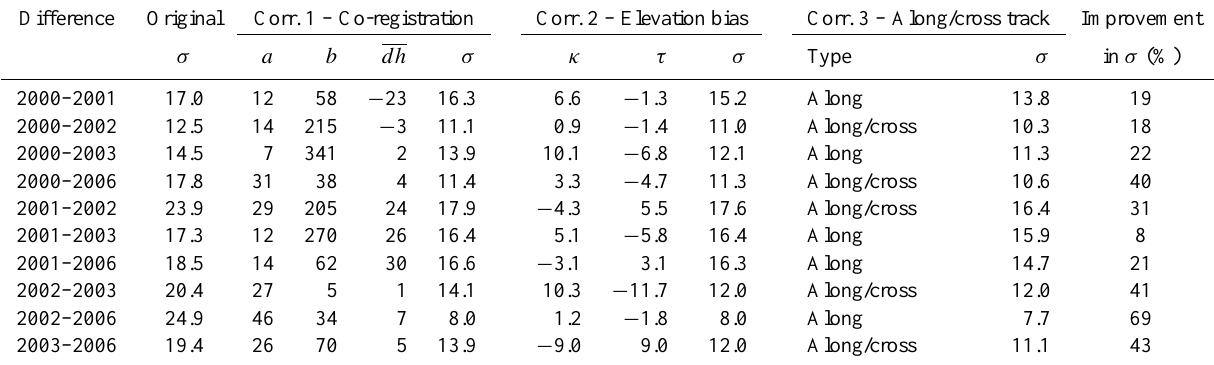
Table 2. New Zealand Southern Alps. ASTER DEM and SRTM difference statistics on stable terrain ( σ ) for the original population of elevation differences after adjusting for the mean and for each correction applied, in sequence. The parameter solutions for the corrections are given for both the co-registration and the elevation bias correction. The improvement of the standard deviation is the total improvement of all three corrections. The units for all parameters are meters except for κ which has the units meters per 1000m.